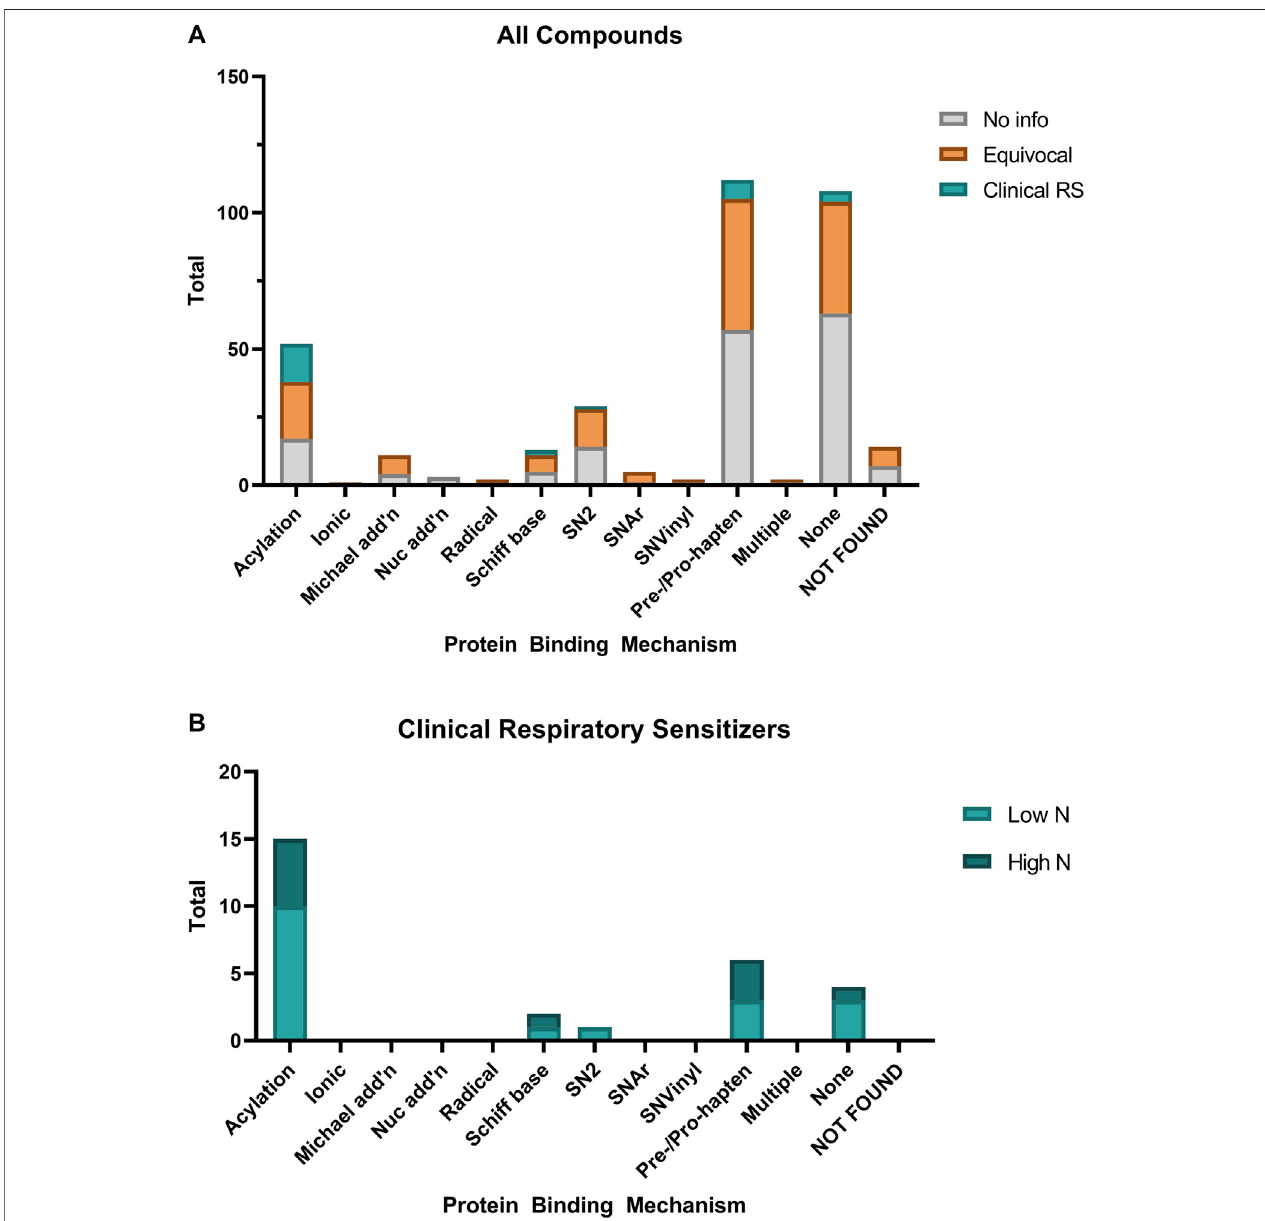
FIGURE 6 | Relative distribution of protein binding mechanisms of (A) all evaluated chemicals compared with (B) the identi fi ed clinical respiratory sensitizers. Protein binding mechanisms were predicted using the OECD QSAR Toolbox. Chemicals which had no protein binding alerts except when predicted metabolites or oxidation products were pro fi led are included as “ Pre/Pro-hapten.